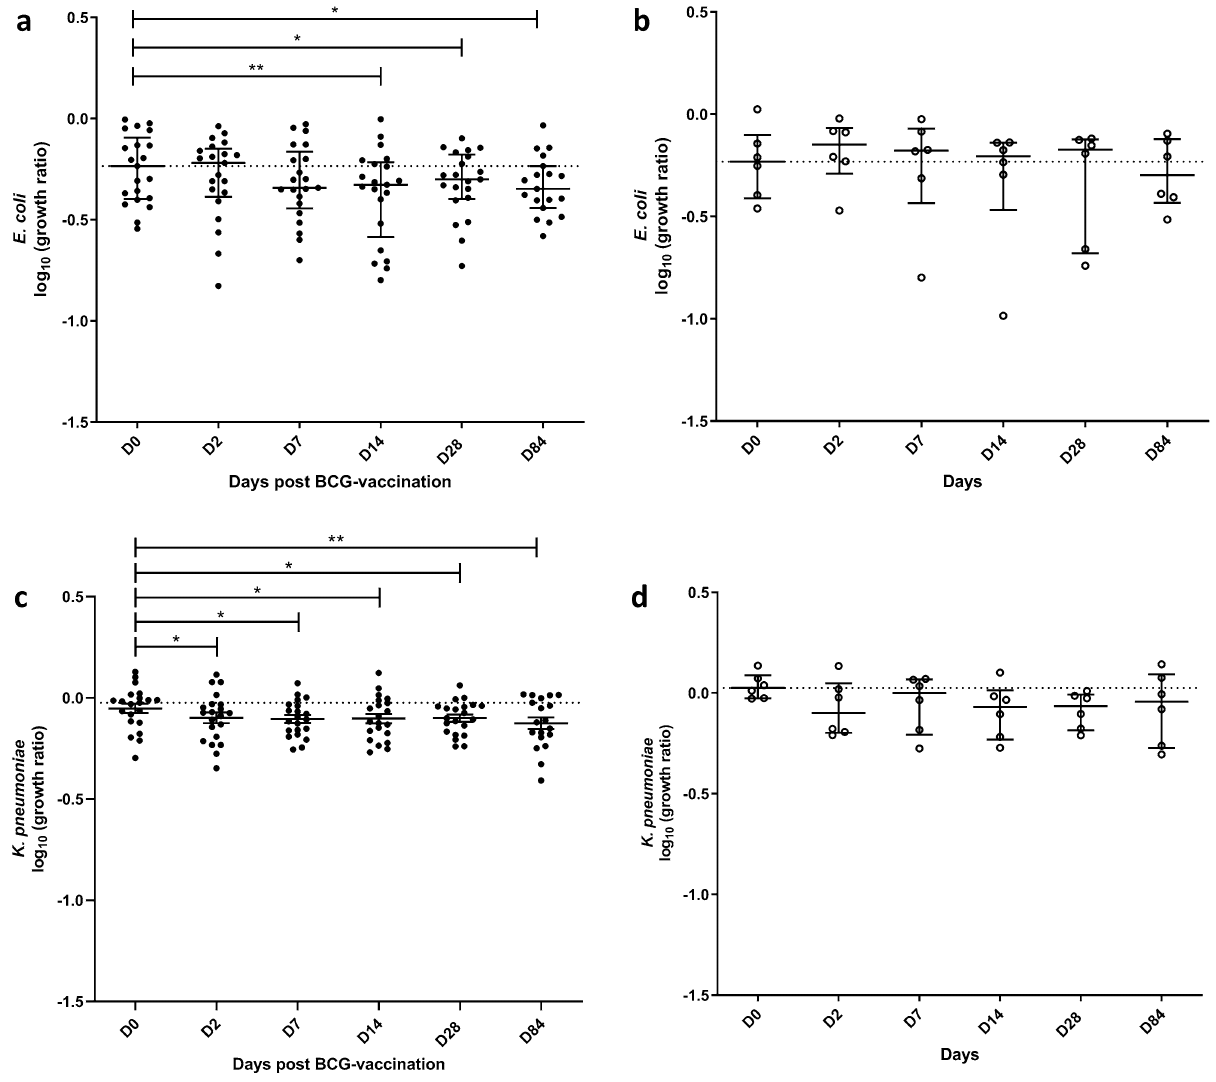
Figure 4. Significant effect of BCG vaccination on growth of Gram-negative bacteria in the PBMC GIA. Samples were taken from volunteers enrolled into phases 1 and 2 combined. Healthy UK adults were randomised to receive BCG vaccination ( n = 27) or to be unvaccinated controls ( n = 8). PBMC bacterial GIAs were conducted on samples taken at baseline and days 2, 7, 14, 28 and 84 following BCG vaccination (closed circles) and at the same time-points in unvaccinated control individuals (open circles). PBMC and autologous serum were co-cultured with E. coli ( a, b ) or K. pneumoniae ( c, d ) for 1 h after which time cells were lysed and bacteria quantified by plating on solid blood agar. Bars represent the median values with the interquartile range (IQR); dotted lines indicate the baseline median. Paired t-tests were performed of each time-point vs. baseline, where *indicates a p -value of < 0.05 and **indicates a p -value of <